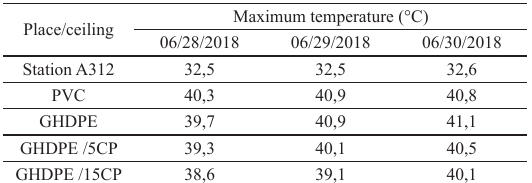
Table 4. Maximum external and internal temperatures obtained in different test days for each prototype.